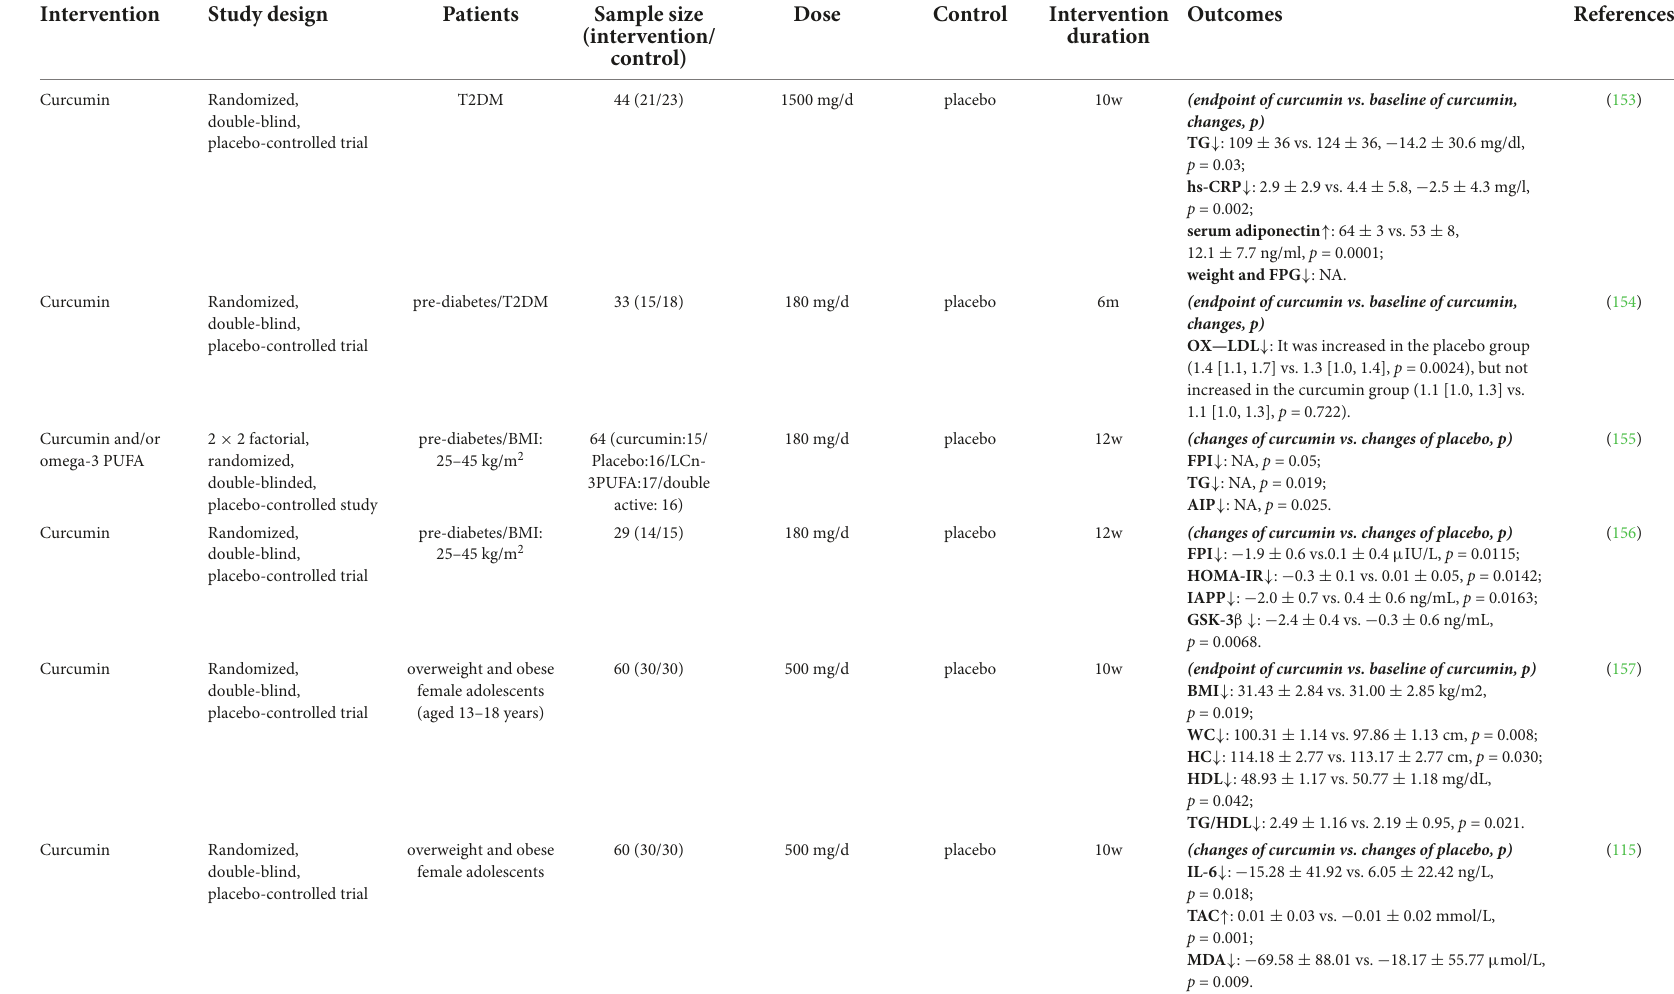
TABLE 1 Clinical evidence (RCT and meta-analysis) of 3 representative natural polyphenols (curcumin, quercetin, and anthocyanin) in alleviating obesity and T2DM.